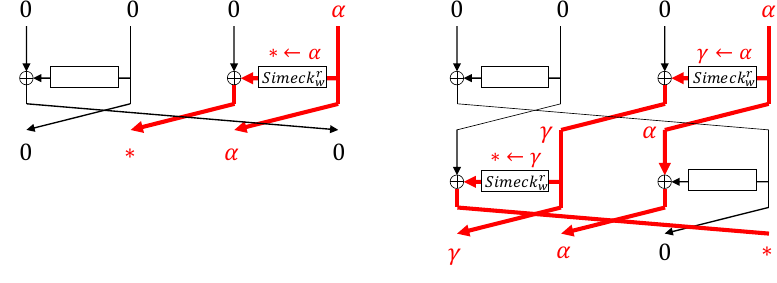
Figure 6: Left: the Last Step of the 15-Step Attack for sLiSCP . Right: the Last Two Steps of the 16-Step Attack for sLiSCP . Several inactive bit positions are specified for γ